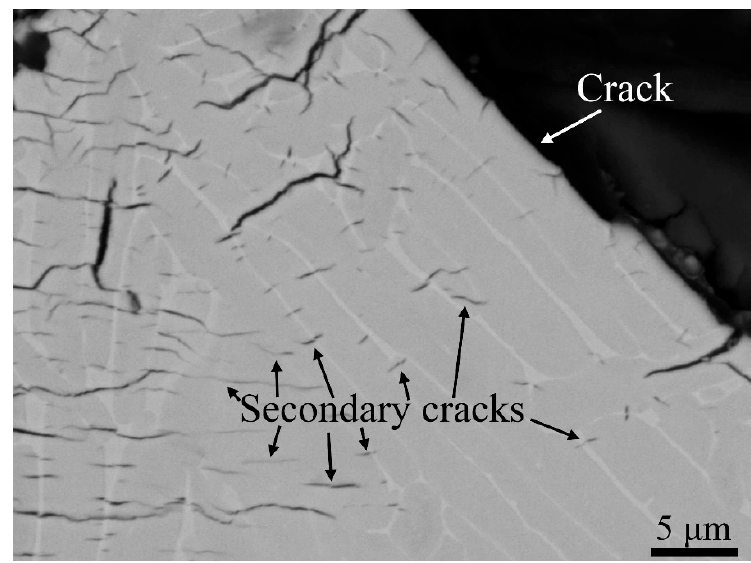
Figure 11. Image of a crack profile for sample H-A. It shows secondary cracks that grow across α / β interfaces. In the upper right corner, the crack propagated along an α lath, seemingly in the α / β interface.